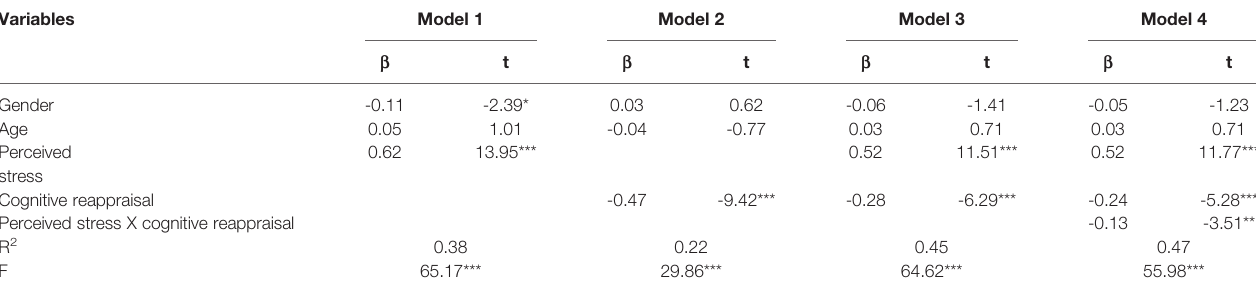
TABLE 3 | OLS regression models examining associations of perceived stress and emotion regulation on depressive